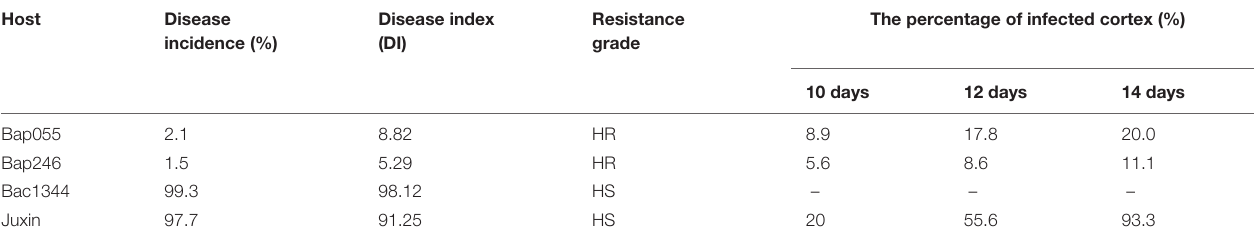
TABLE 1 | Disease index of Chinese cabbage hosts in greenhouse trials and the percentage of infected cortex.